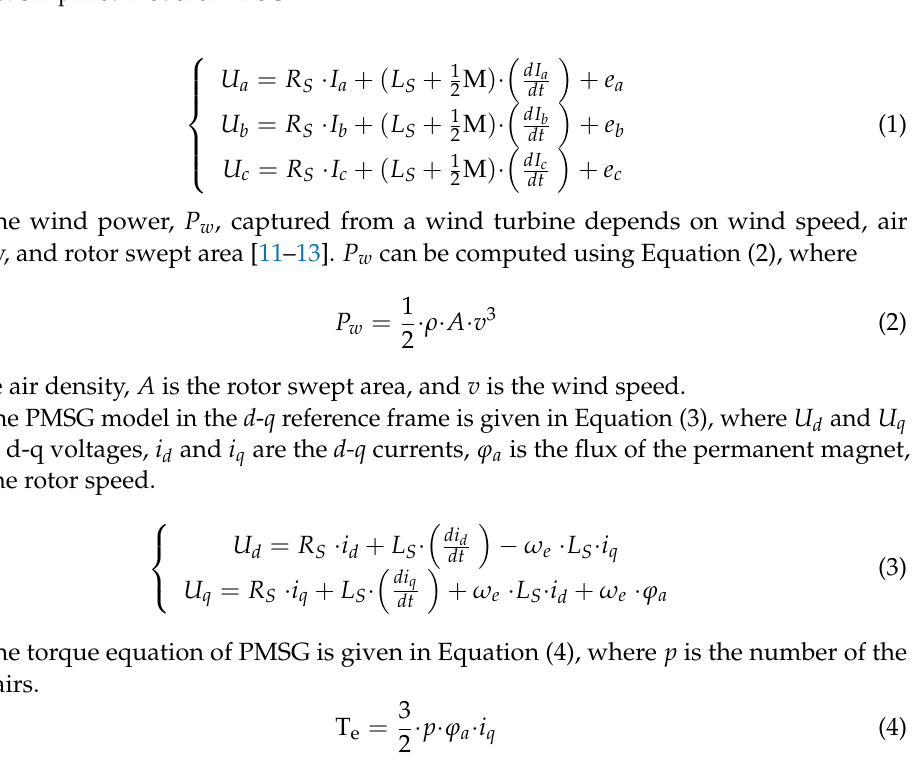
Figure 3. Simplified model of